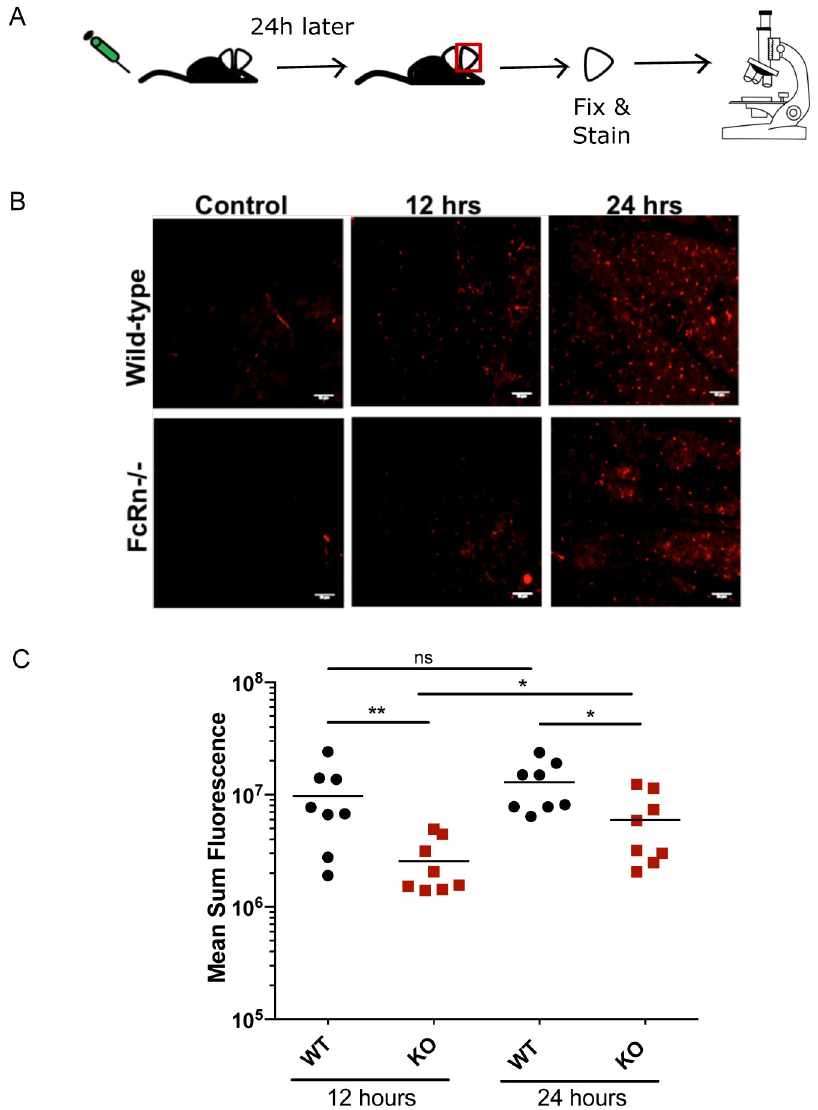
Fig 2. Kinetics of labeling of Langerhans cells in FcRn -/- mice and wild-type mice. (A) . Schematic of the experimental workflow: Wild-type and FcRn -/- mice were IV inoculated with 12.5 μ g of anti-Langerin mAb either 12 hrs or 24 hrs prior to ear harvest. After excision, ears were fixed and stained with a secondary antibody. Controls were not inoculated with anti-Langerin mAb prior to ear removal but were stained with secondary antibody. All ears were imaged using confocal microscopy. (B) Representative maximum projection images of Langerhans cell staining in Wild-type and FcRn -/- mice (scale bar = 35 μ m). (C) Dot plot showing the mean sum fluorescence of labeled Langerhans cells in each image (n = 2 images/ear), with the line representing the mean. Data from two independent experiments were pooled. Statistical comparisons were performed using two-tailed Mann-Whitney tests on the pooled data ( * = p < 0.05; ** = p < 0.01). The sum fluorescence was calculated using relative fluorescence units (RFU), with each spot representing the mean sum fluorescence in one image. Identical exposure times were used for all images.